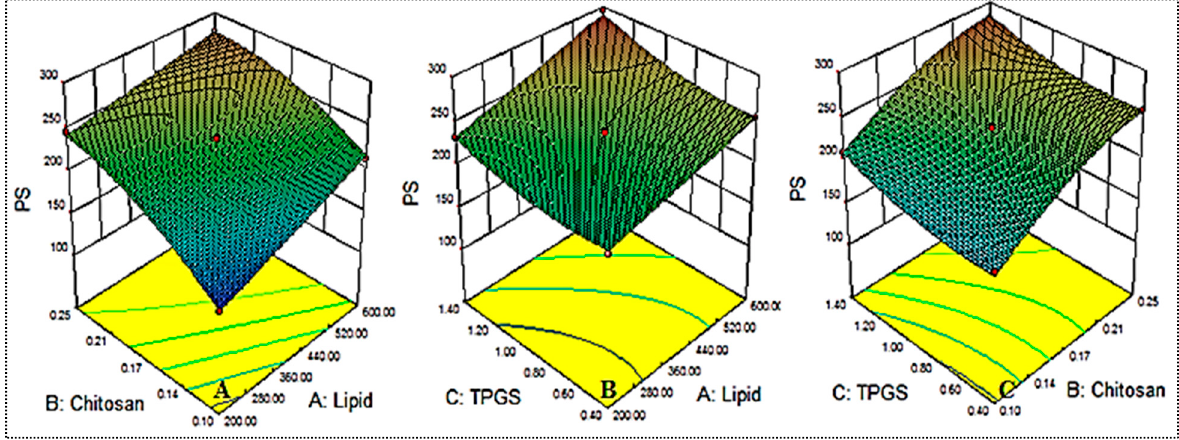
Figure 1. Effect of the constraints used ((lipid ( A ), chitosan ( B ), TPGS ( C ) = on particle size (Y 1